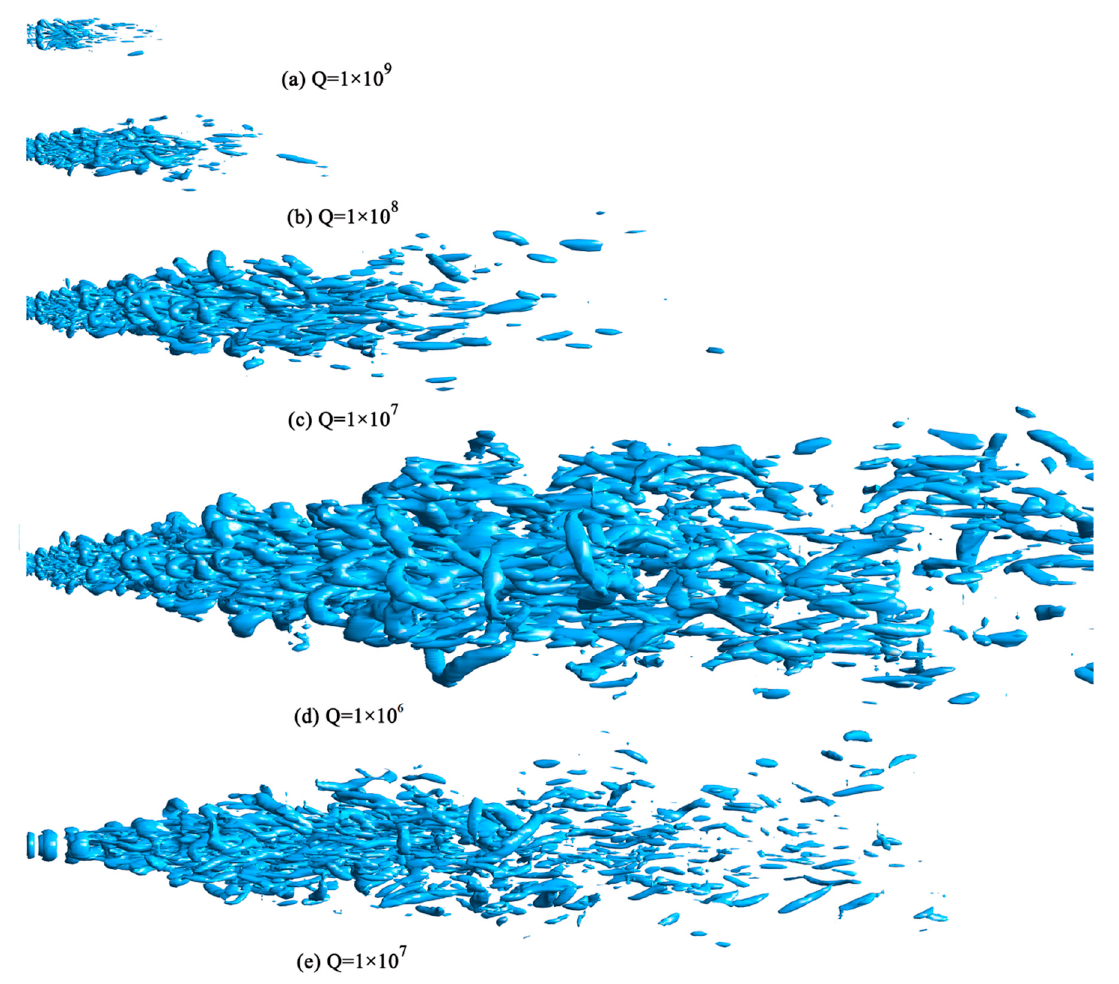
Figure 13. The coherent structure of SPEOJ flow under di ff erent Q-criterion